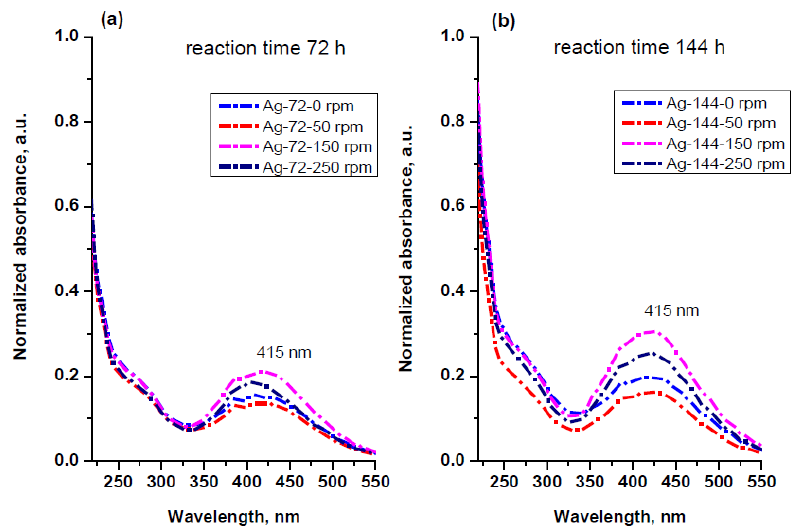
Figure 8. UV–Vis spectra of the aqueous dispersions of AgNPs isolated from the reaction mixtures stirred at 0, 50, 150 and 250 rpm after ( a ) 72 h reaction time and ( b ) 144 h reaction time.